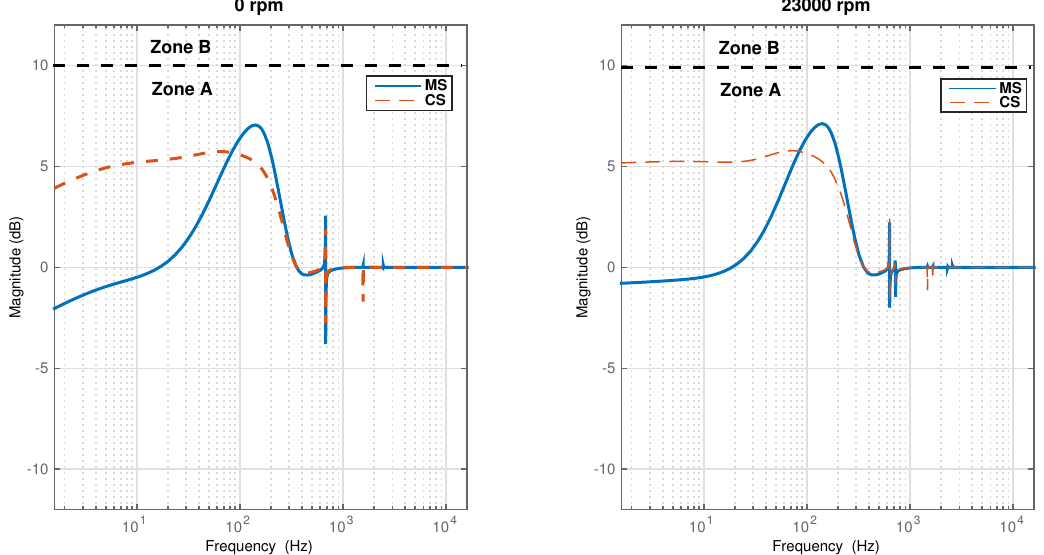
Figure 21. Magnitude plots of the sensitivity functions at zero and maximum continuous speed under the FOPID controllers tuned by the DE